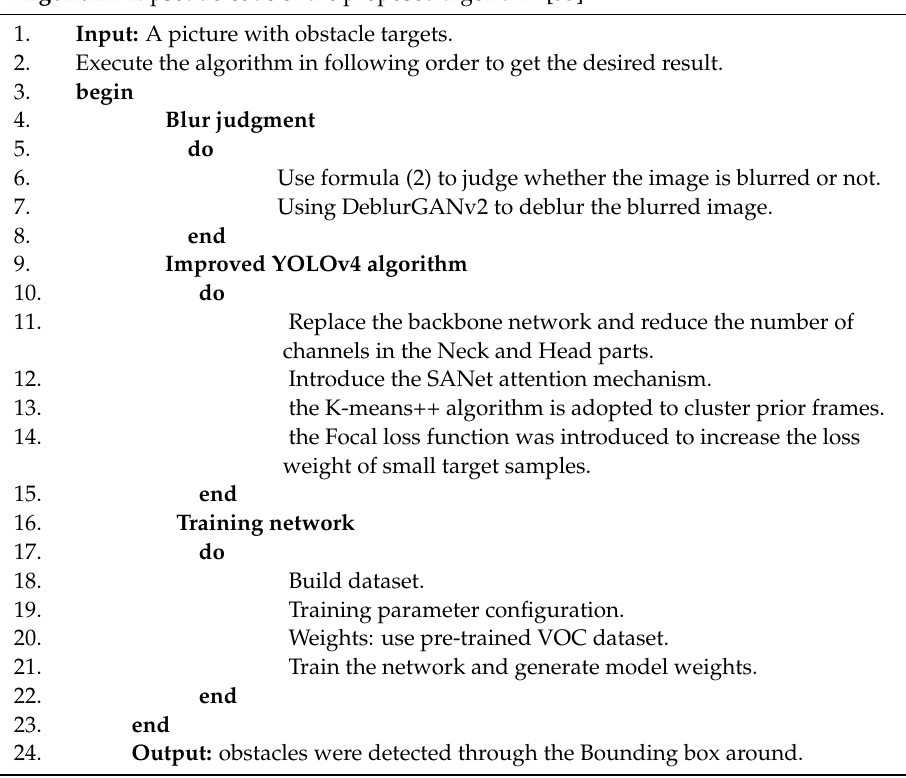
Algorithm 1: pseudo code of the proposed algorithm